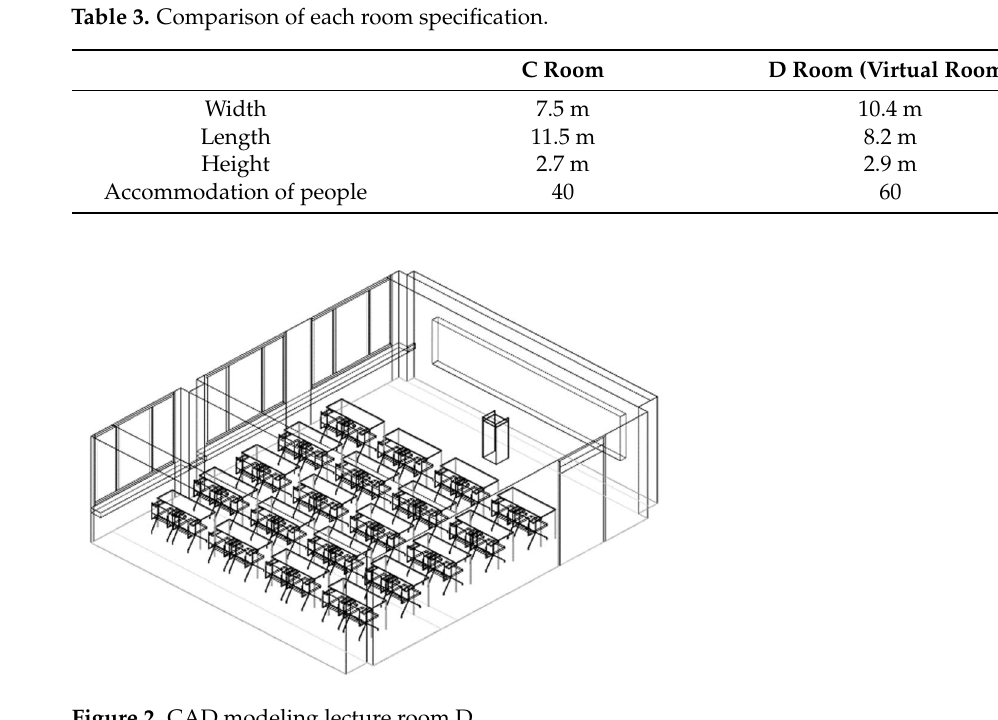
Figure 2. CAD modeling lecture room D.